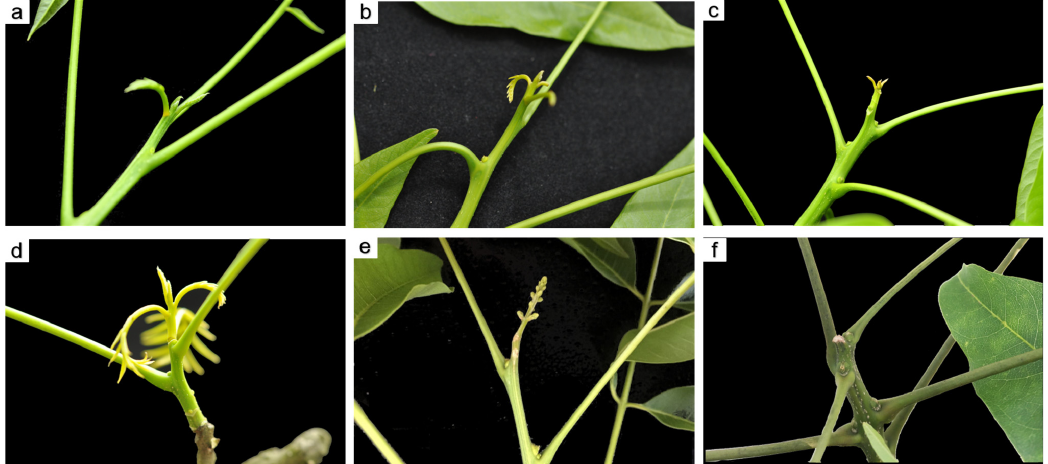
Figure 4. Developmental dynamics of vegetative shoots. ( a ) yellowing of the base of the undeveloped leaf blade at the top of the new shoot; ( b ) the top growth point of the new shoot stops growing completely, and all new leaf blades that are not fully developed turn yellow; ( c ) undeveloped new leaves of the new shoots fall o ff and an obvious abscission mark can be seen; ( d ) top of new shoot that has not grown into in fl orescences falls o ff ; ( e ) top of new shoot that has grown an in fl orescence falls o ff ; ( f ) vegetative shoot that developed completely. Table 1. Proportion of BSs among the current-year new shoots for 10 Sapindus mukorossi trees from 2016 to 2018. No.